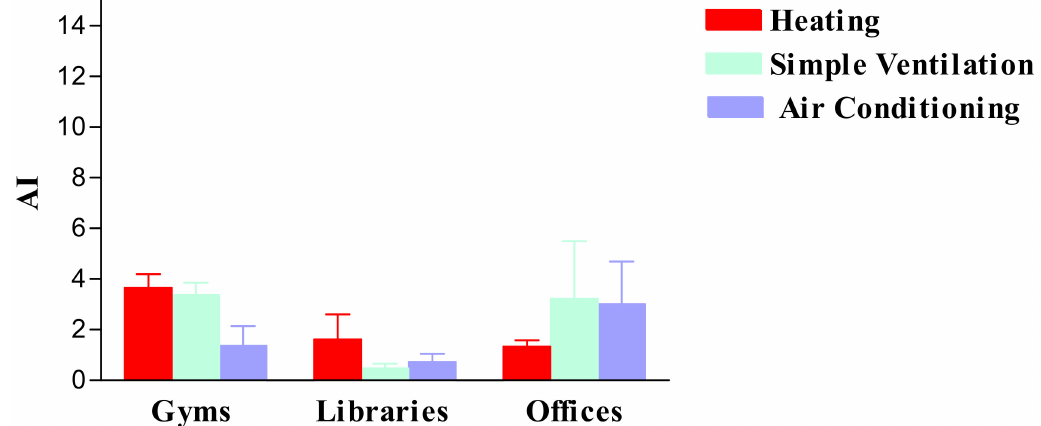
Figure 1. Amplification Index of microbial contamination (AI) measured in the three types of environments during heating, air conditioning, and simple